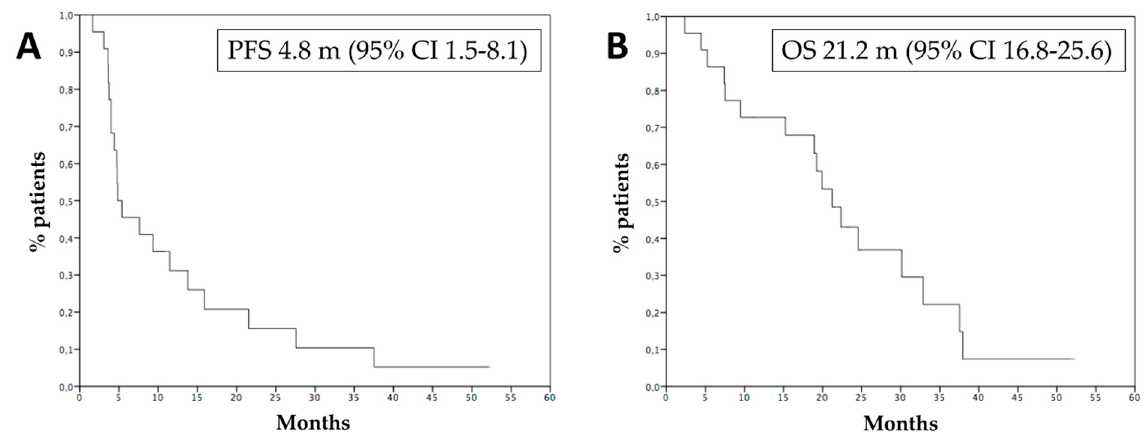
Figure 2. Progression-free survival ( A ) and overall survival ( B ) of the patients treated with hepatic radiotherapy and anti-PD-1. m: months.